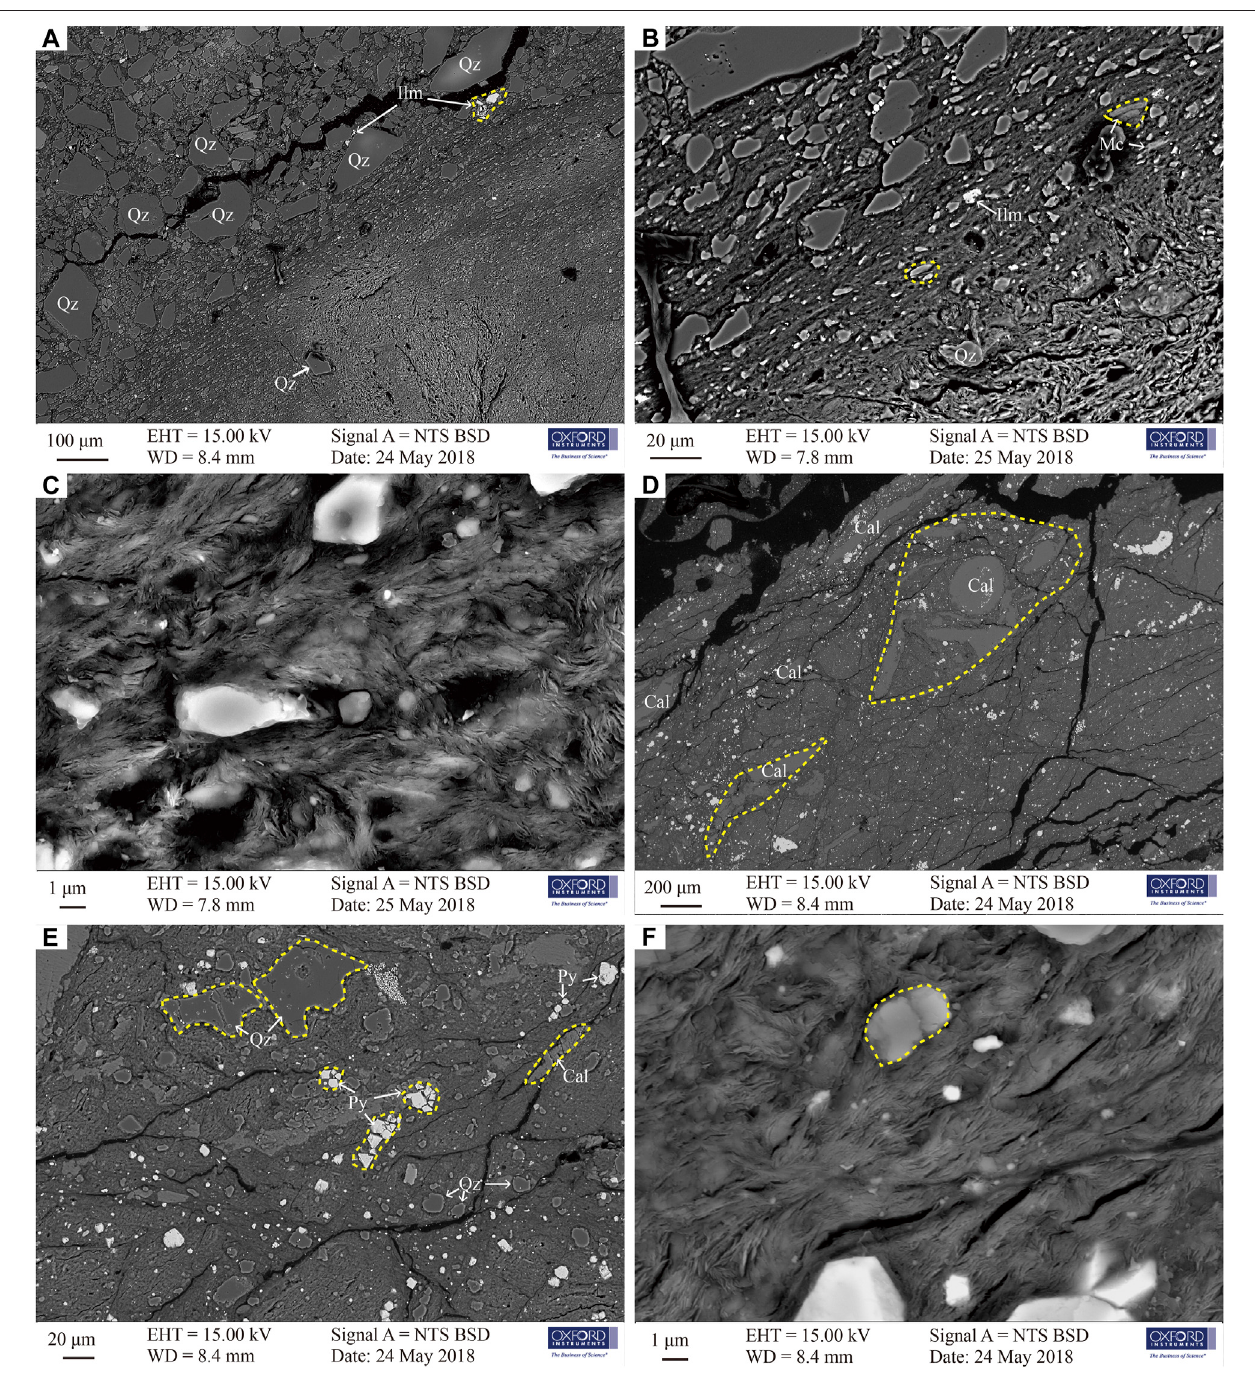
FIGURE 8 | Scanning electron microscope (SEM) images of the fault gouge samples DC4-1 (A – C) and XH4 (D – F) . Qz, quartz; Ilm, ilmenite; Cal, calcite; Mc, microcline; and Py, pyrite. Yellow dashed lines mark reworked clasts.